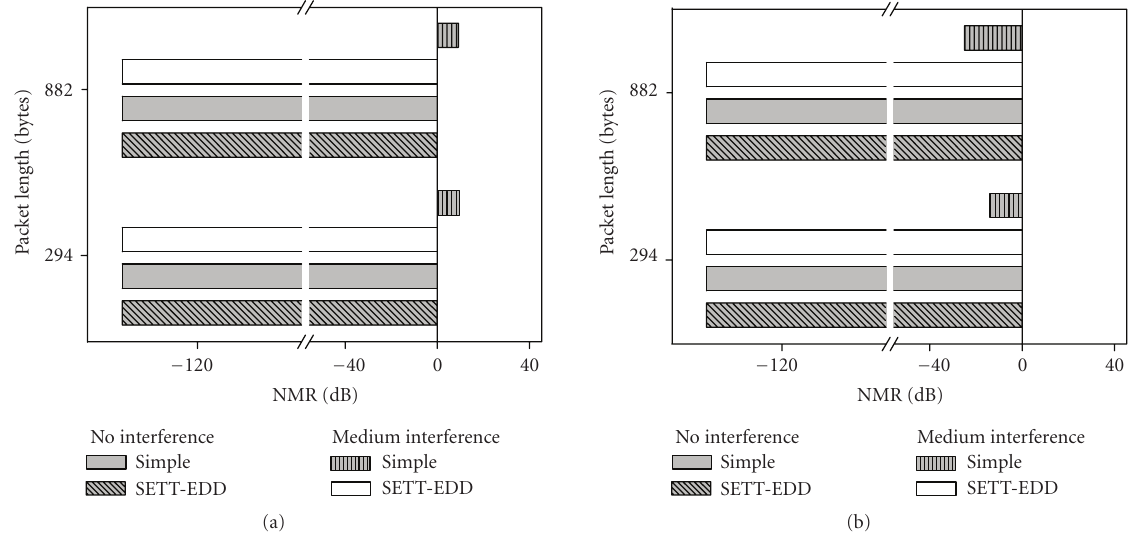
Figure 9: NMR values for 1-channel PCM audio WLAN streaming delivery: (a) CoDeS disabled; (b) CoDeS enabled.